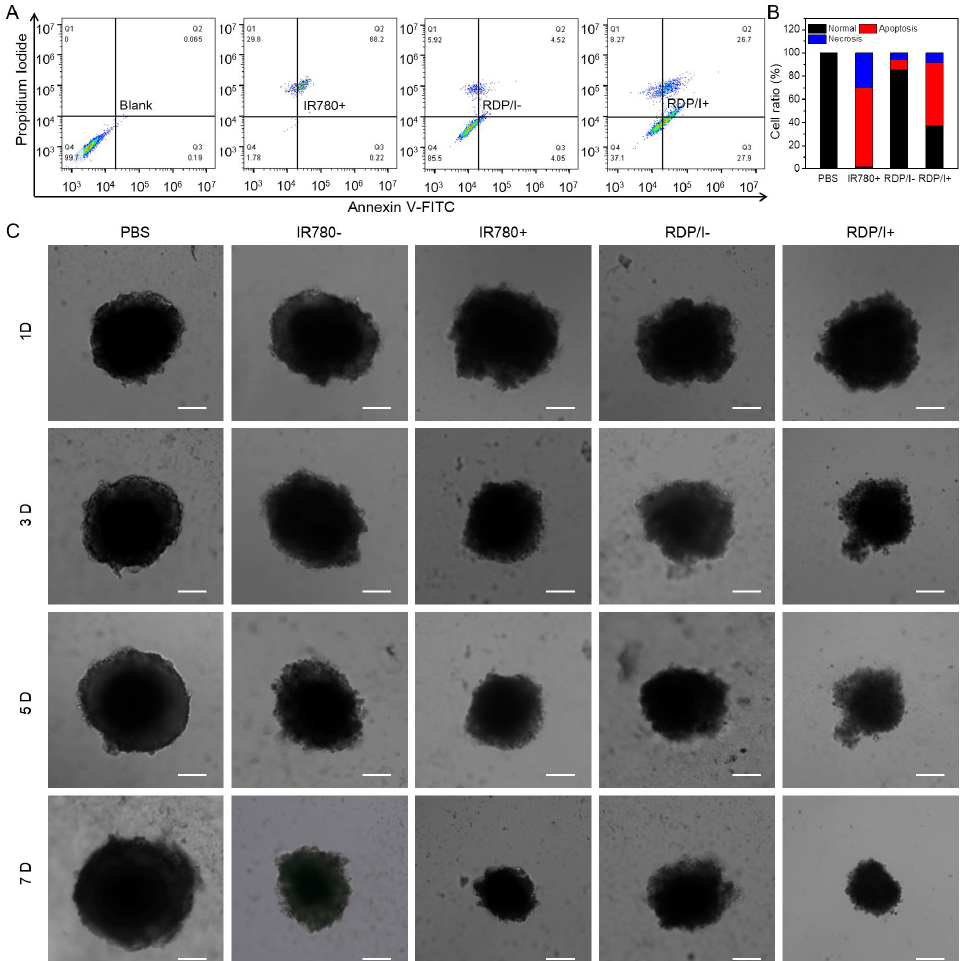
Figure 6. ( A , B ) Quantitative measurement of apoptosis by AnnexinV-FITC/PI in CT26 cells after treated with samples in the absent or present of NIR irradiation (808 nm, 1 W, 1 min); ( C ) growth inhibition of CT26 cells spheroids after treated with samples in the absent or present of NIR irradiation (808 nm, 1 W, 1 min); scale bar: 100 μm.